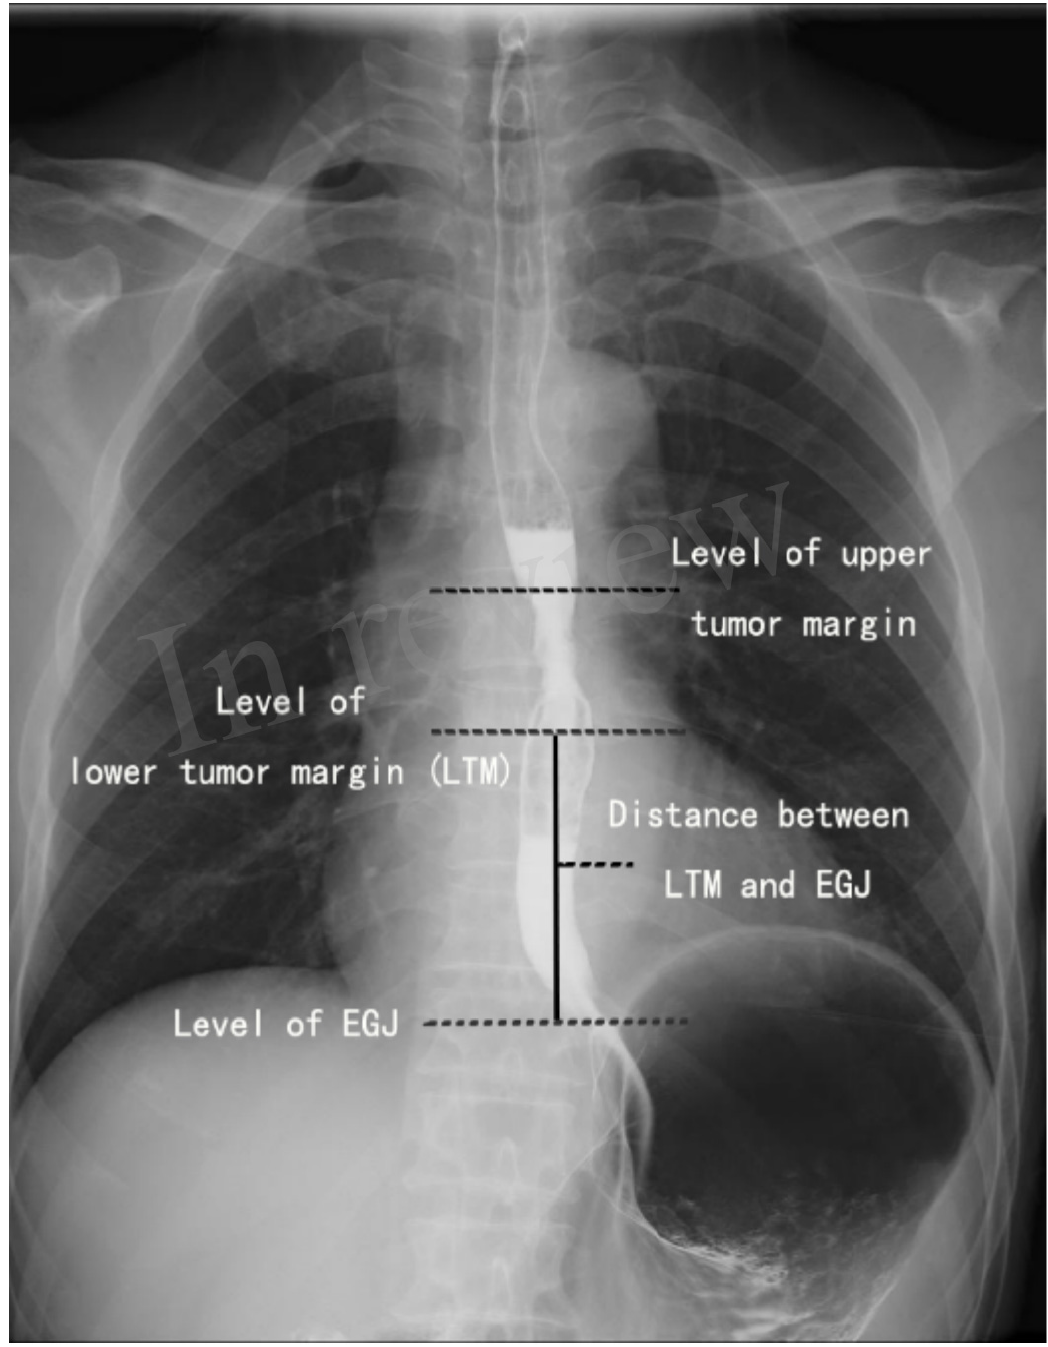
Figure 1. Measurement of the distance between the lower tumor margin and esophagogastric junction.